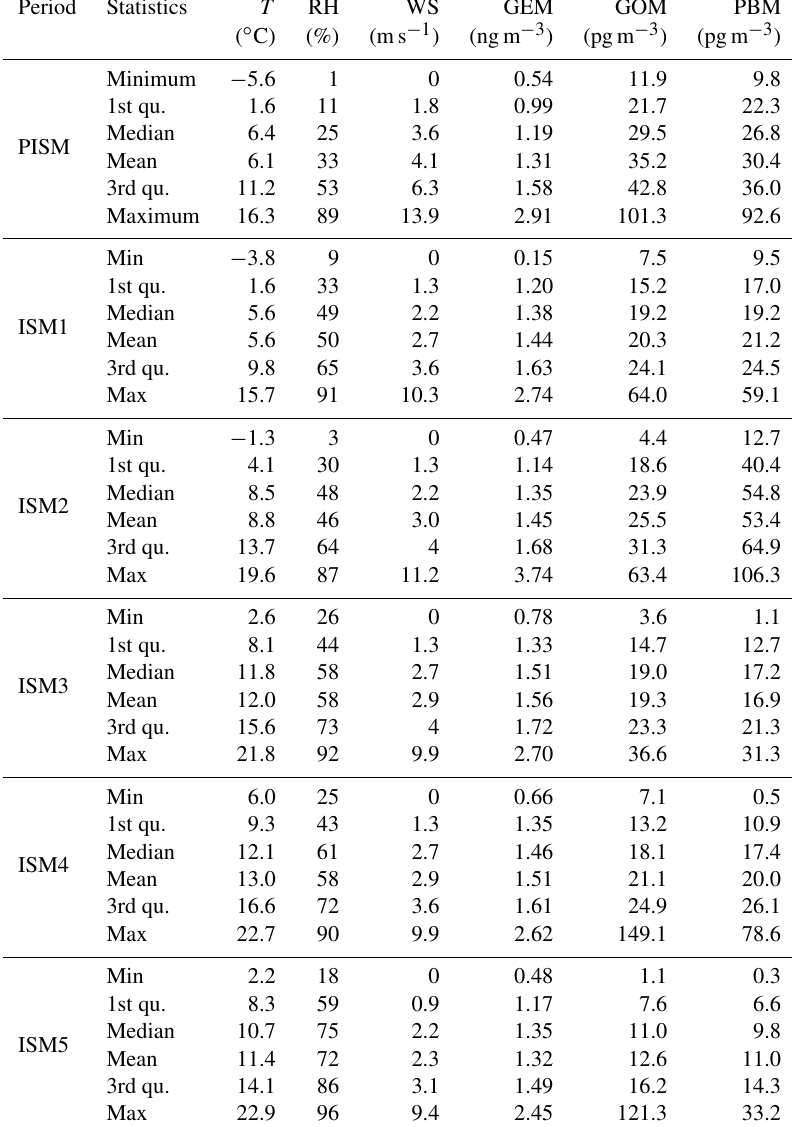
Table 1. Statistical metrics of GEM, GOM, PBM and meteorological variables at the Qomolangma National Nature Preserve. T : temperature, RH: relative humidity, WS: wind